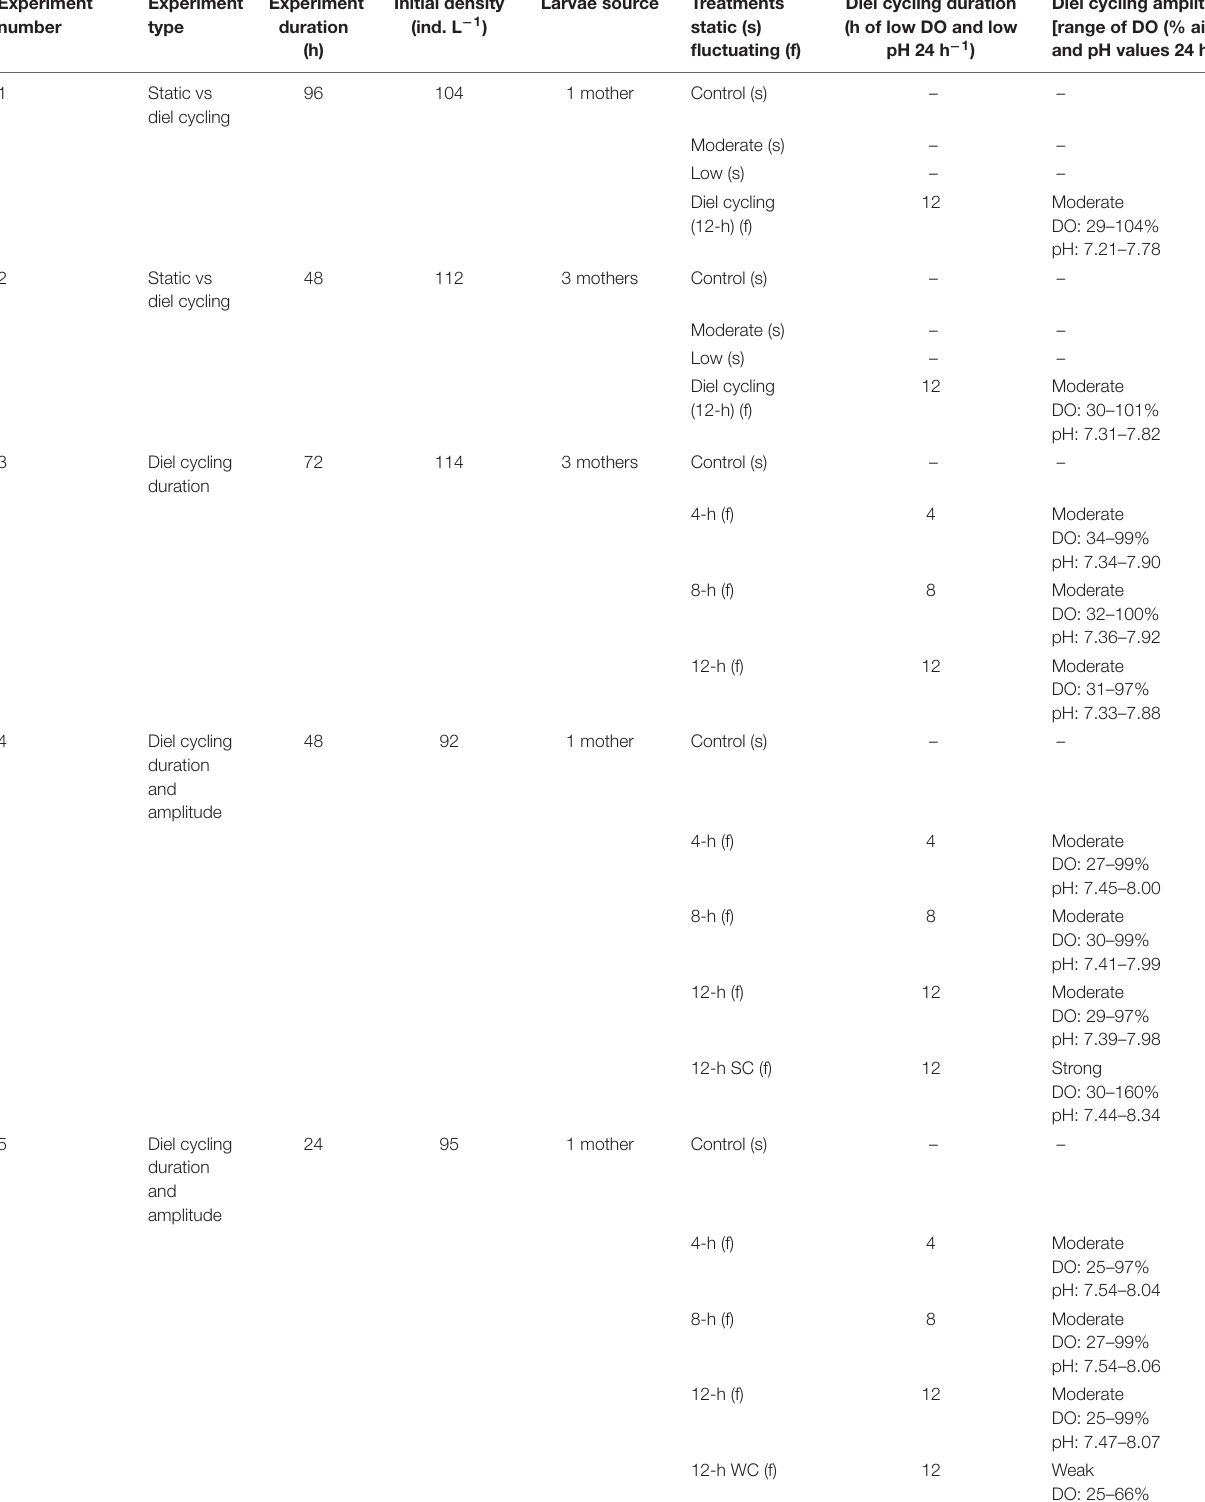
TABLE 1 | Overview of experimental conditions for five experiments investigating the survival of Callinectes sapidus zoea I larvae to diel cycling hypoxia and acidification. Experiment Experiment number